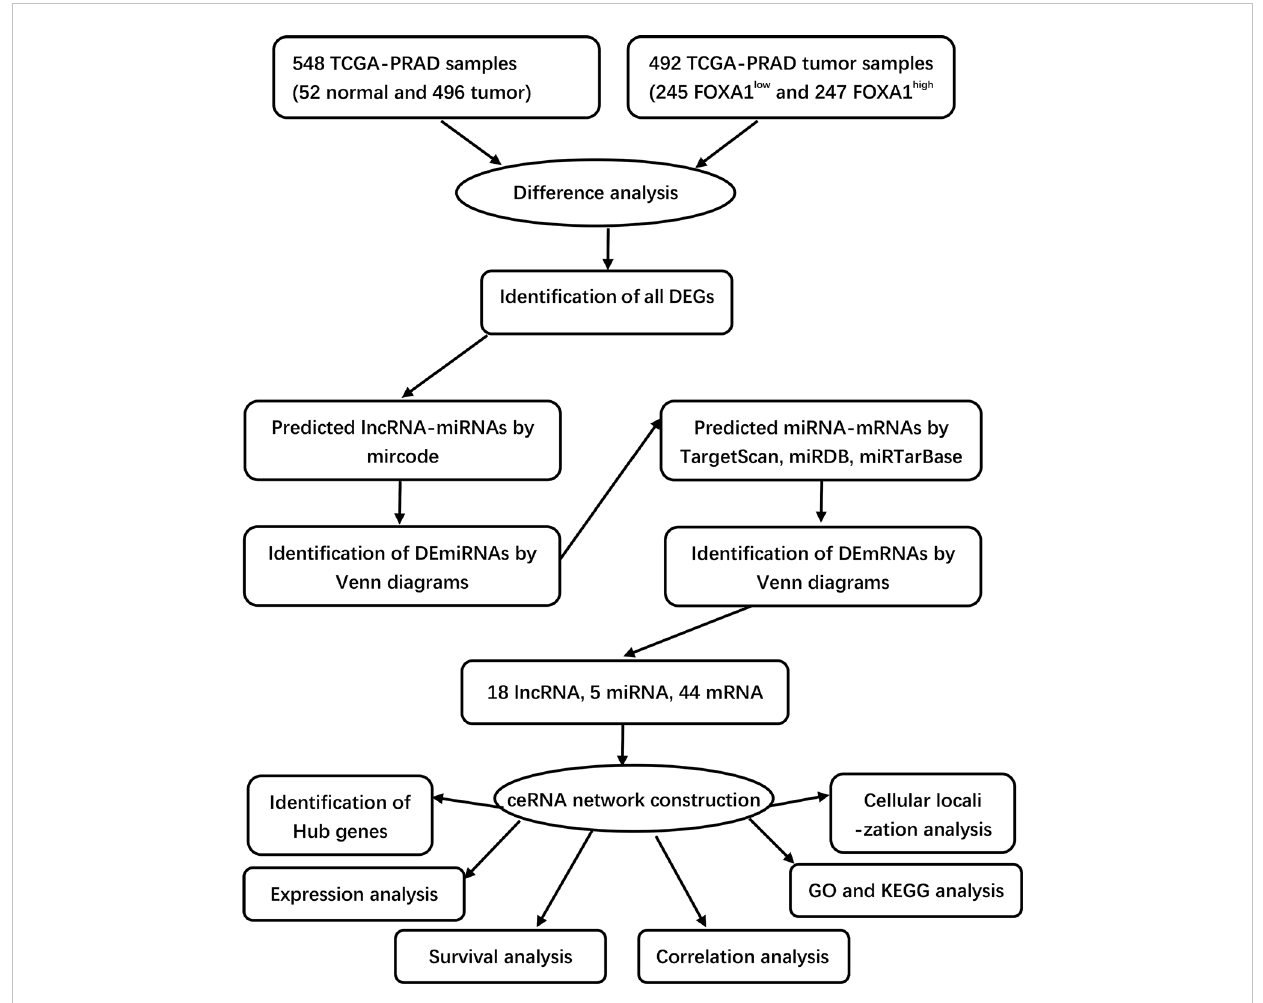
FIGURE 1 Flowchart of construction and analysis of